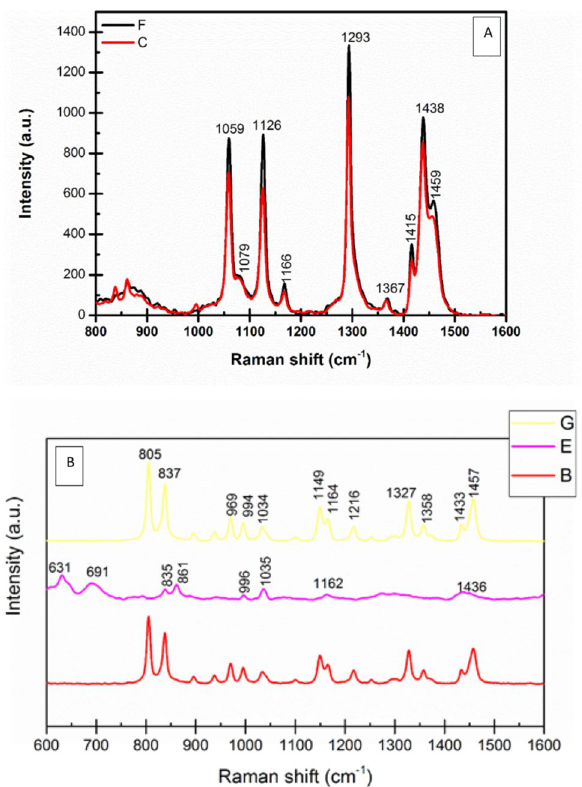
Fig. 2 a Raman spectrum of the PE base samples before (F) and after (C) exposure to bacterial strain C, b Raman spectrum of the PP base sample before (G) and after (B and E) exposure to B and E bacterial strains